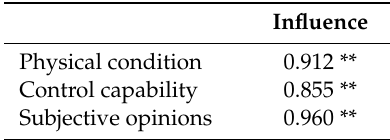
Table 5. Pearson coefficient of correlation.